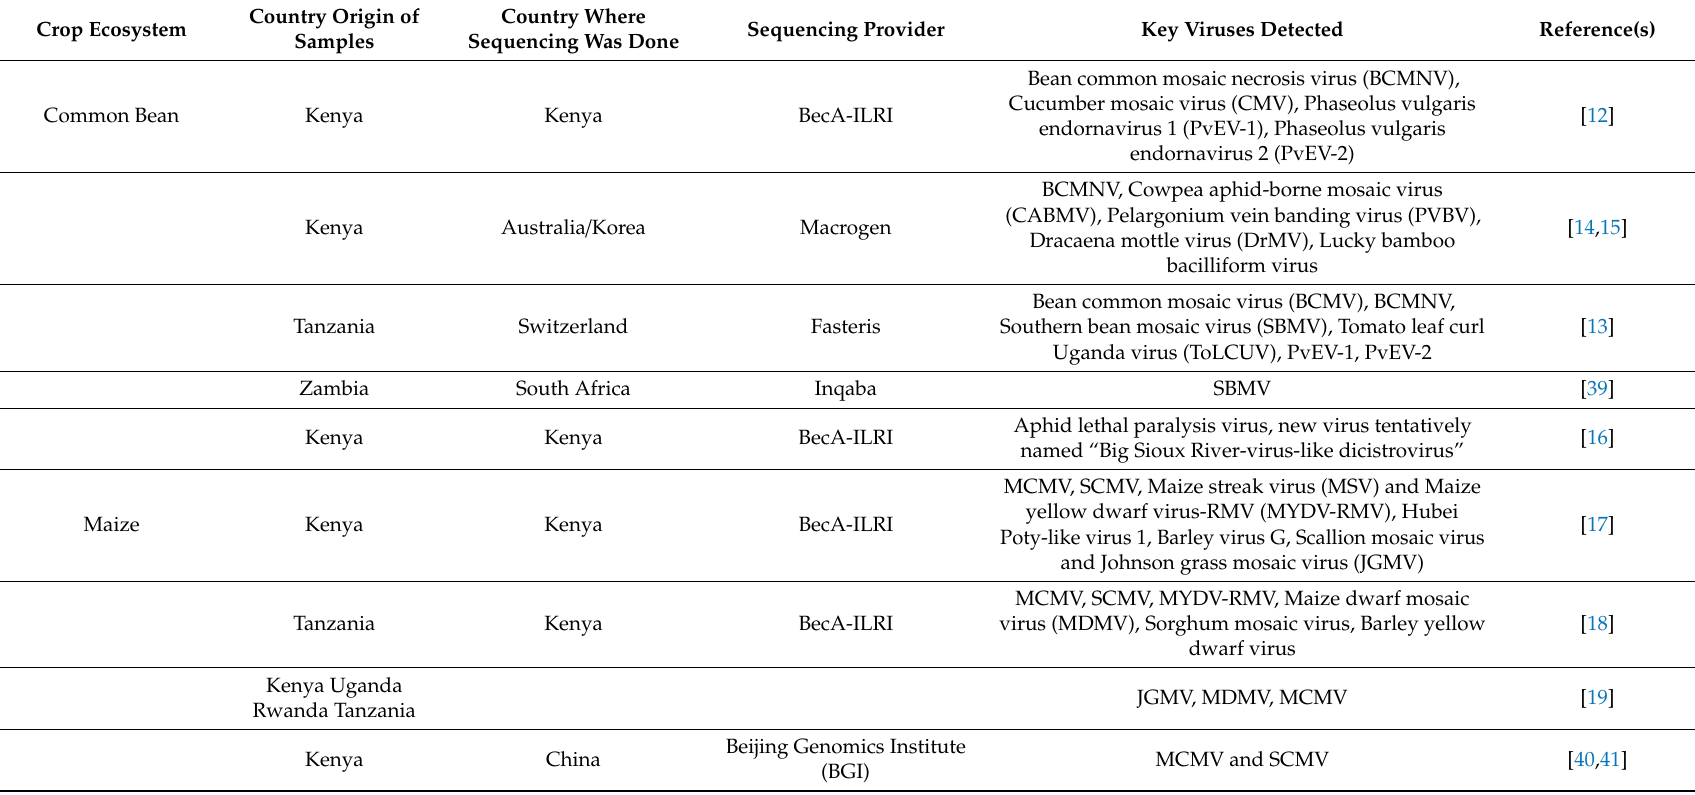
Table 1. Recent use of high-throughput sequencing (HTS) for virus discovery in some of Africa’s food